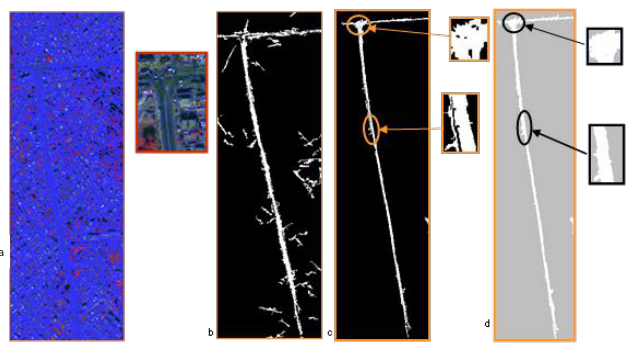
Figure 2 (a) Segmented image (b) Road Class (c) Refined road class (d) Final road extracted Insets: Areas needing